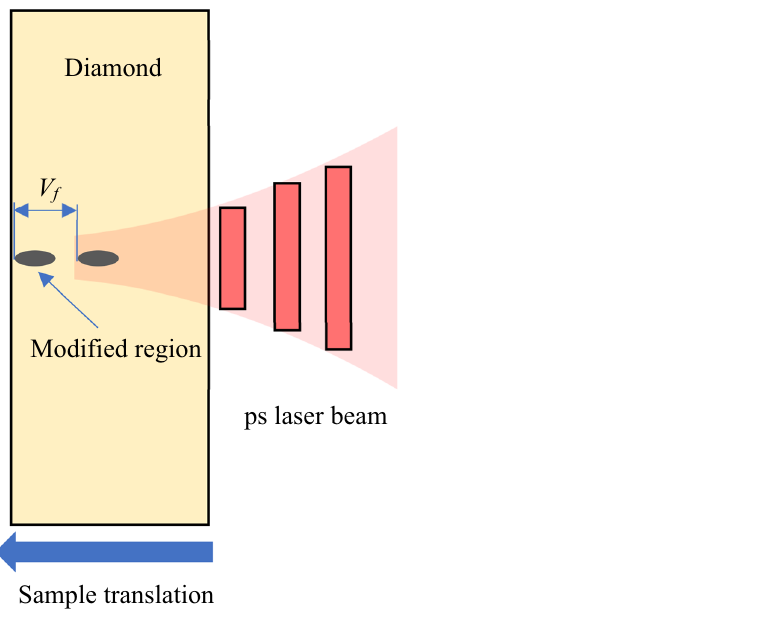
Figure 7. Schematic illustration of experimental